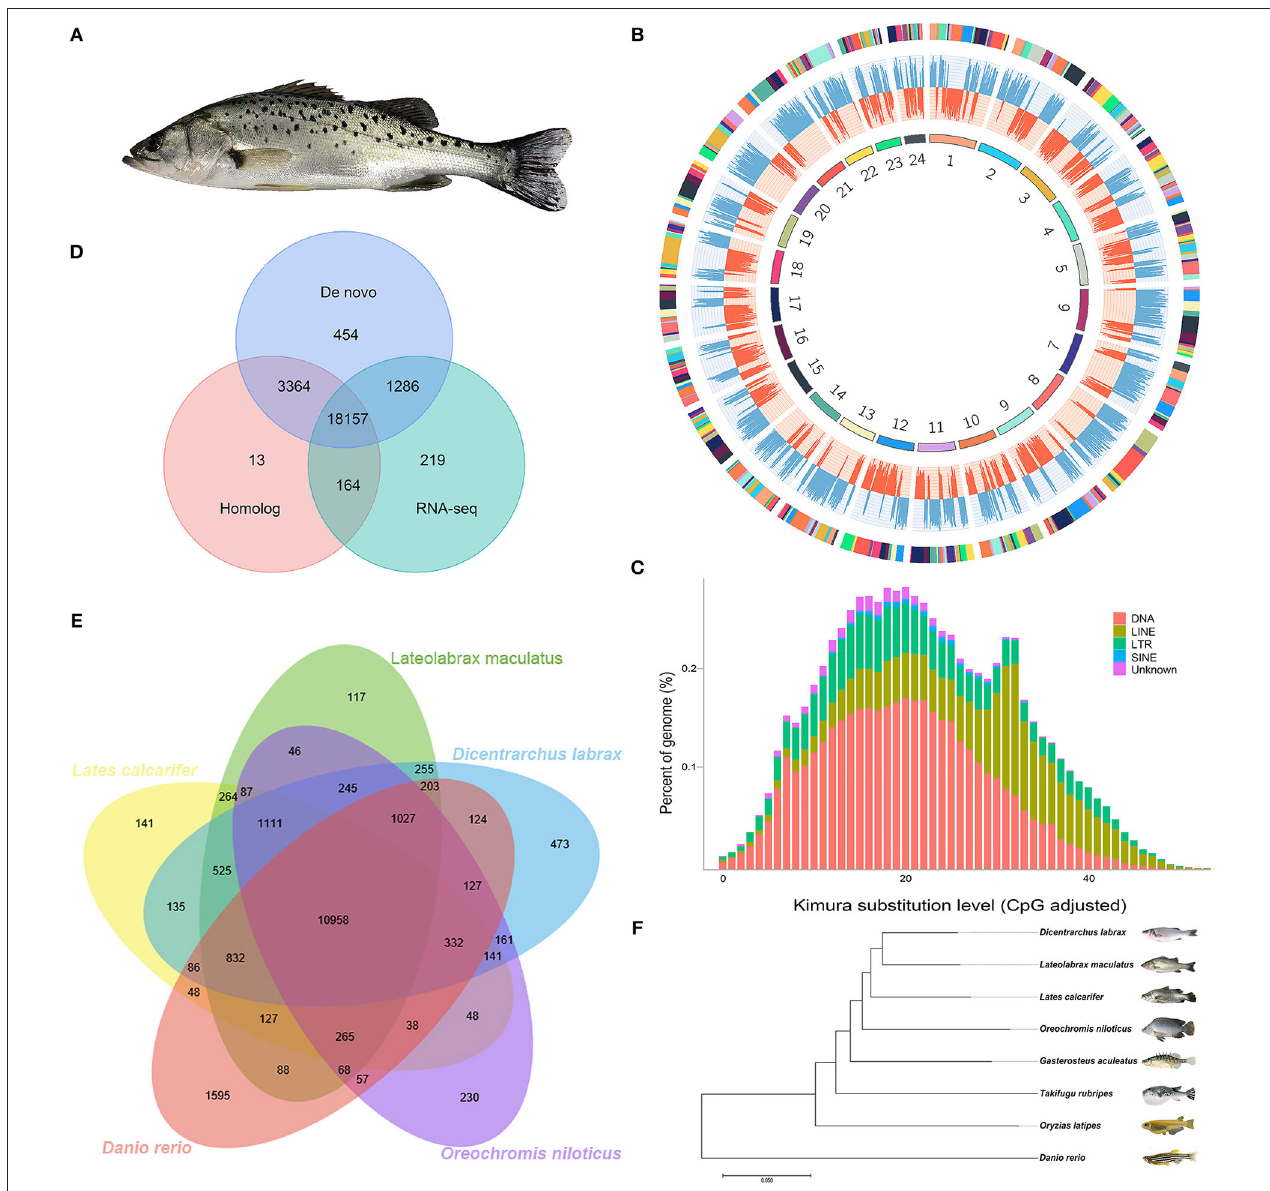
FIGURE 1 | Characteristics of Lateolabrax maculatus genome assembly. (A) A picture showing about Chinese seabass, L. maculatus . (B) A circos plot of 24 chromosomes in L. maculatus genome, the tracks from inside to outside are: 24 chromosomes, gene abundance of the positive strand (red), gene abundance of the negative strand (blue), and scaffolds which comprised the chromosome (adjacent contigs on a chromosome are painted in different colors). (C) Divergence distribution of TEs in L. maculatus Genome. (D) A venn diagram indicating the number of genes predicted by three different approaches. (E) A venn diagram showing orthologous gene families across five fish genomes. (F) Evolutionary relationships among eight